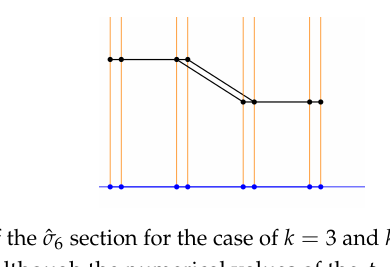
Figure 11. A comparison of the ˆ σ 6 section for the case of k = 3 and k = 6 and p = 2. One notes that the general shape is the same although the numerical values of the φ i change. All sets of sections exhibit this type of similarity across values of k . Increasing k shifts the fiber positions to the